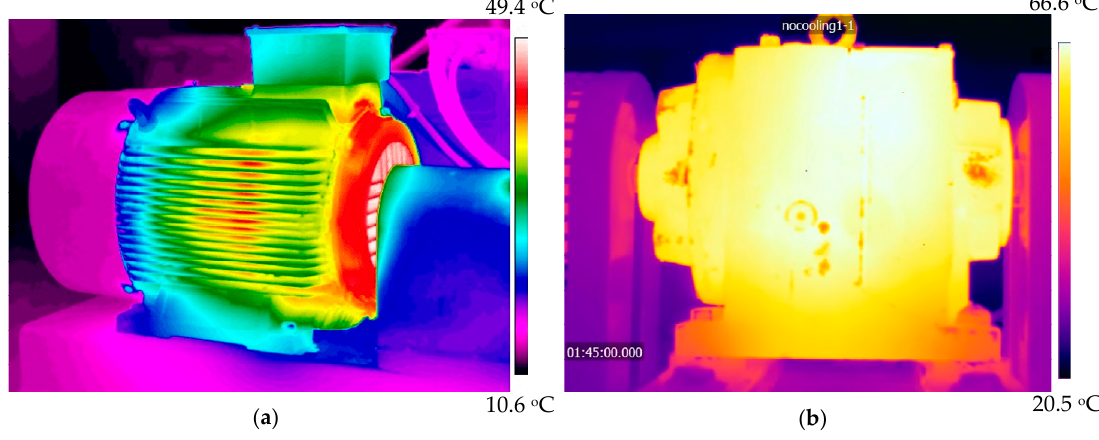
Figure 4 . Local thermal imaging of mechanical components: ( a ) Motor; ( b ) Gearbox housing. Figure 4. Local thermal imaging of mechanical components: ( a ) Motor; ( b ) Gearbox